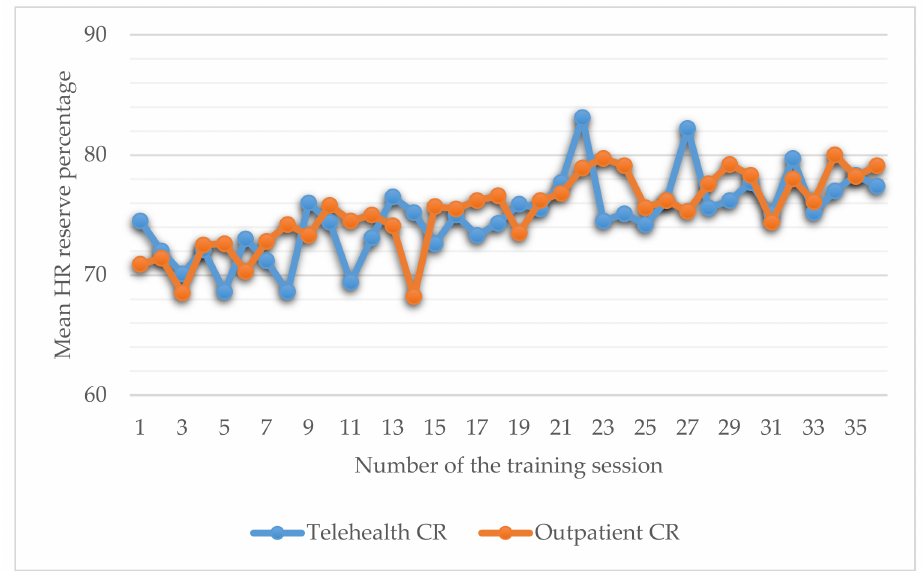
Figure 3. Graphic representation of training intensity between study